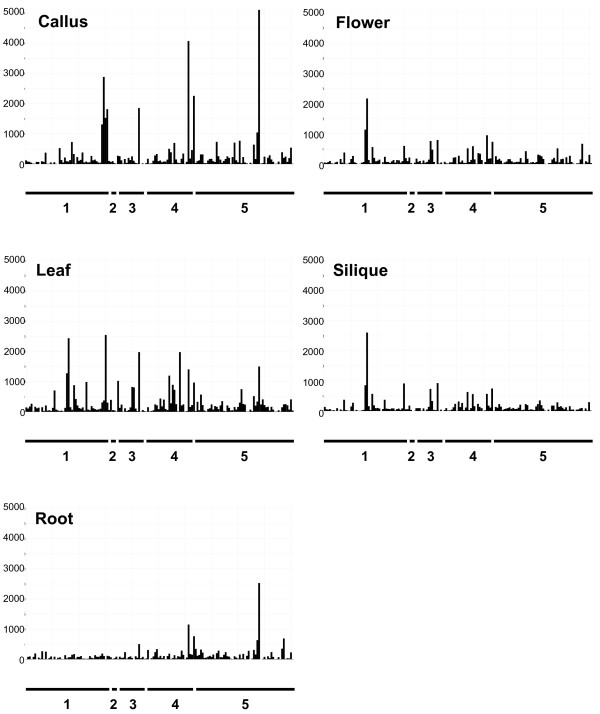
The expression level of 162 NBS-LRR-encoding and related genes in five different tissues of Arabidopsis wild-type Col-0. All NBS-LRR-encoding and related genes are ordered according to their At numbers along the X axis. Each Arabidopsis chromosome is indicated below each graph. Y-axis indicates the relative expression level of each probe set after scaling the mean intensity of each ATH1 microarray to 500.